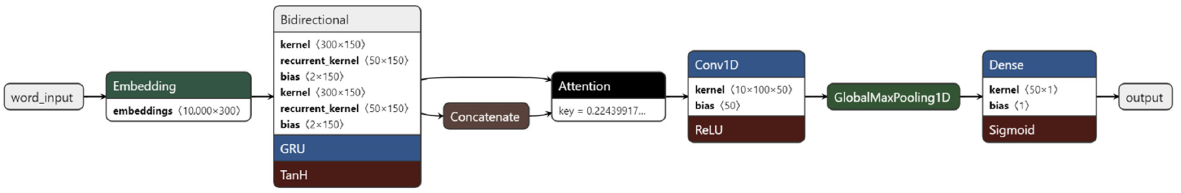
Figure 4. Implemented GRU ‐ CNN with bidirectional GRU .